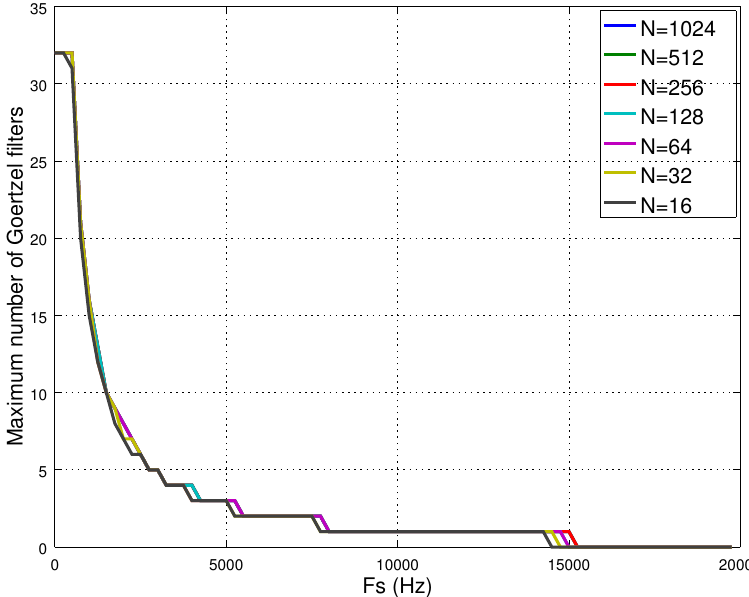
Figure 10. Theoretical maximum number of Goertzel filters as a function of the sampling rate ( F s ) and number of iterations (N). Each curve has been obtained by taking into account the room in the memory hosting filter objects and the time available to compute them.